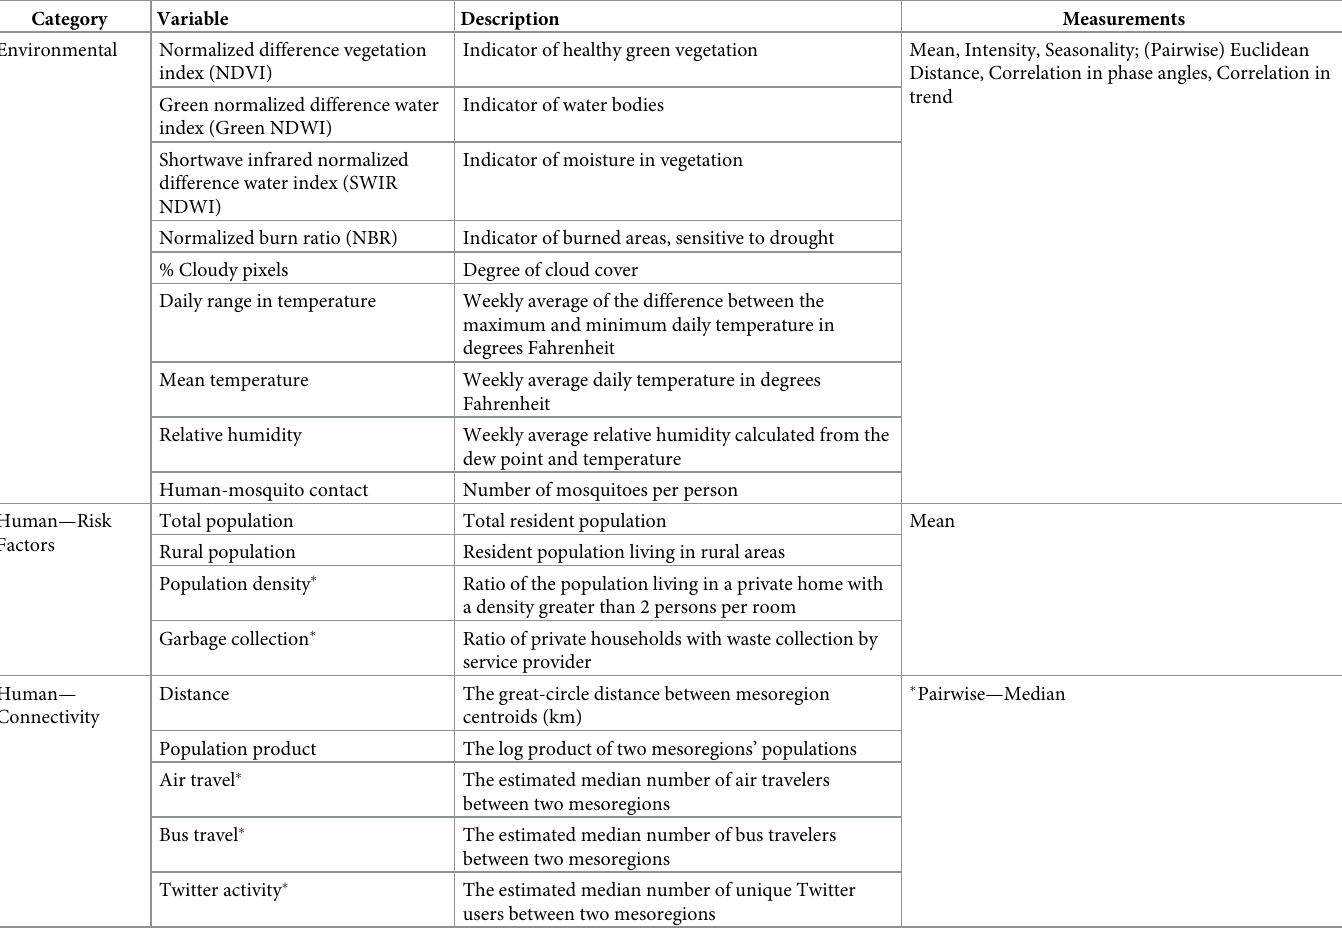
Table 1. Candidate covariates for explaining outbreak properties. Measurements indicate the different ways in which a variable was incorporated as a candidate in the LASSO regression models.